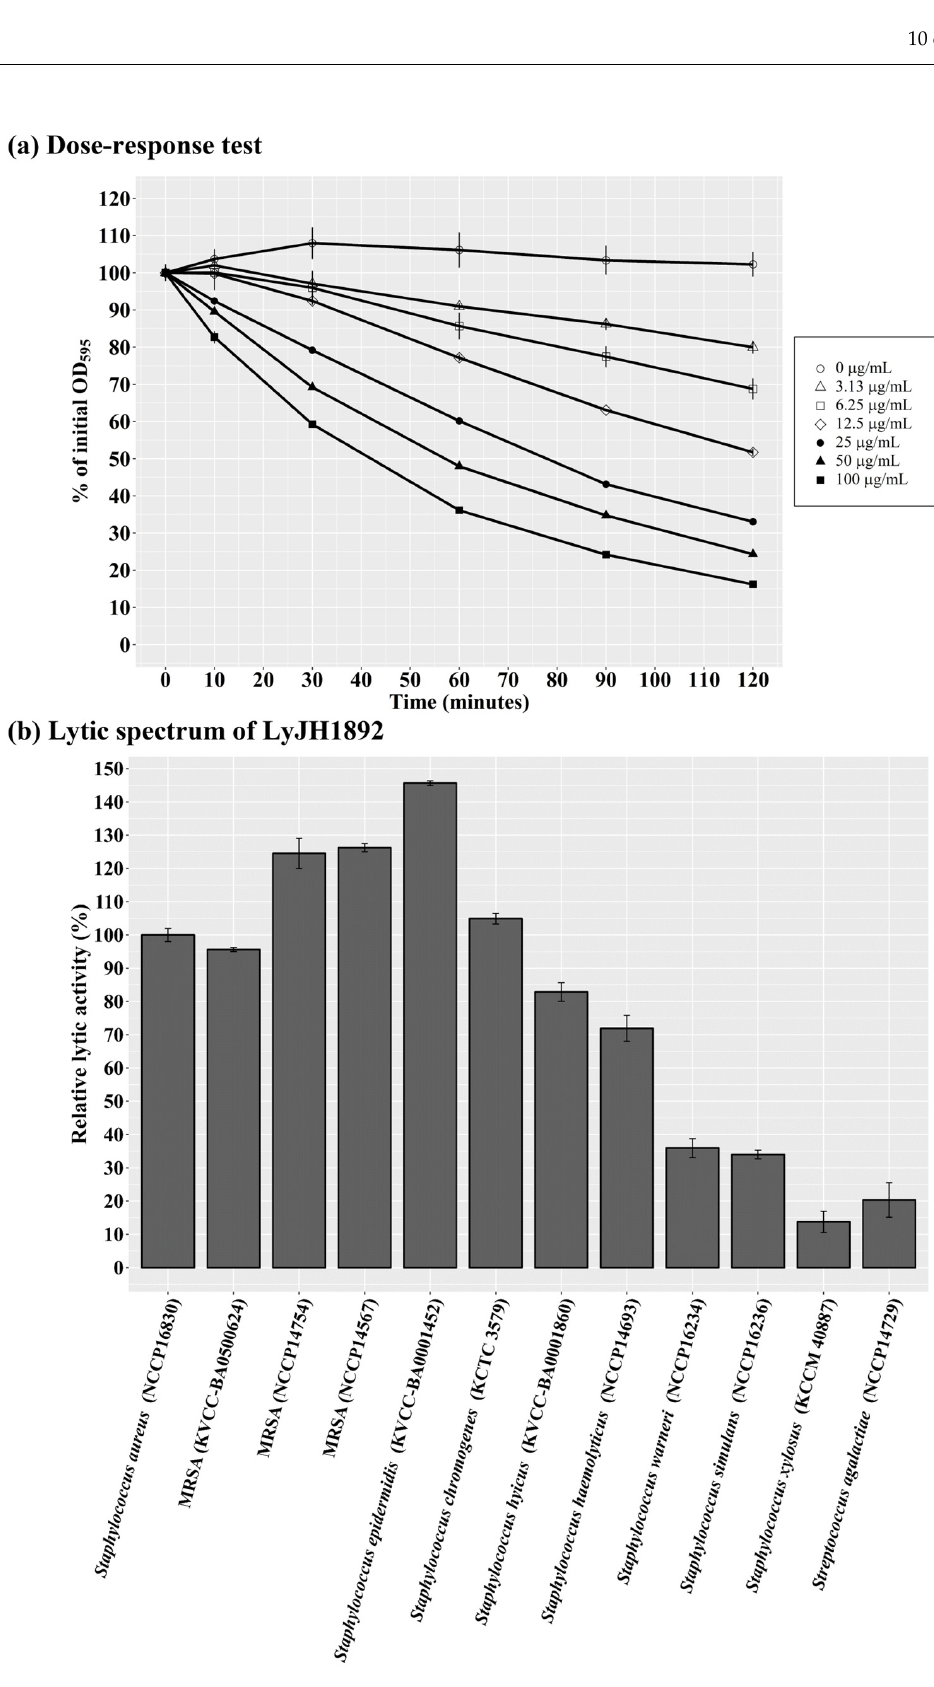
Figure 6. Optimal lytic activity and lytic spectrum of LyJH1892. ( a ) Dose–response test against Staphylococcus aureus (NCCP 16830). ( b ) A lytic spectrum of LyJH1892. All lytic tests were performed under optimal conditions of LyJH1892 (pH 9.0, 25 °C, and no addition of NaCl and metal ions). Data are shown as means ± standard deviation of triplicate assays.